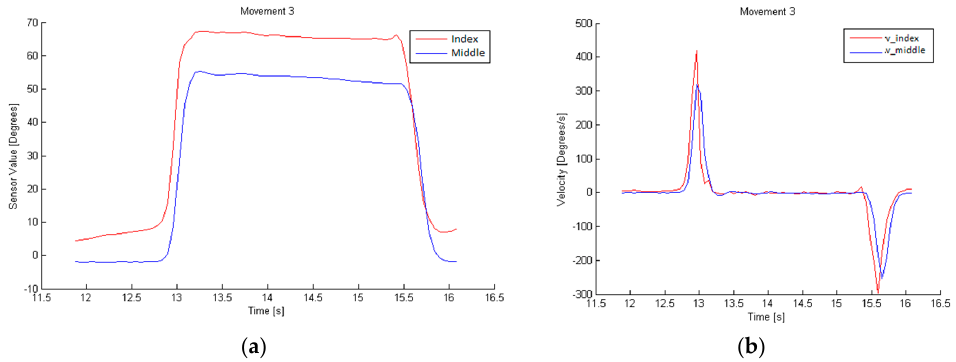
Figure 9. ( a ) Glove sensor data, which are proportional to the flexion of the finger in movement 3; ( b ) Velocity of the flexion involved in movement 3.